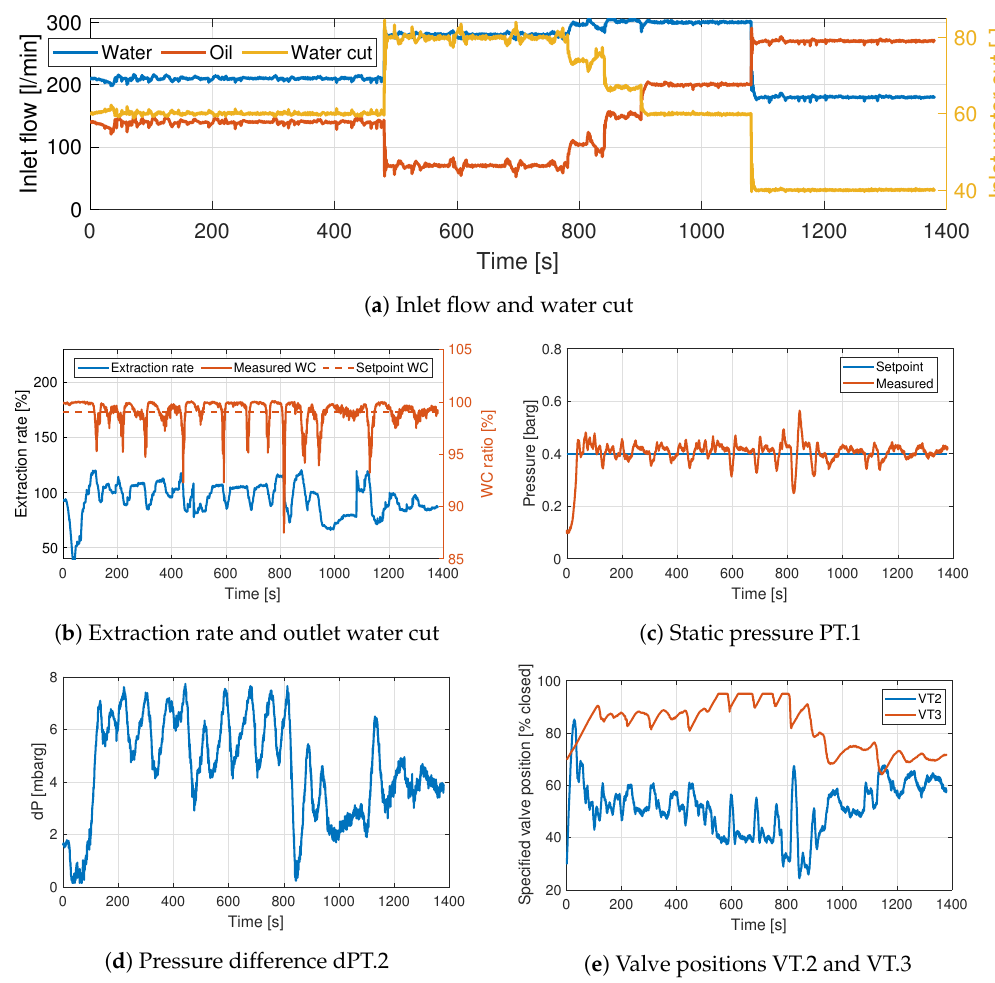
Figure 7. Experiment 1. PI controllers on VT.2 and VT.3 where VT.2 controls PT.1 and VT.3 controls WC r